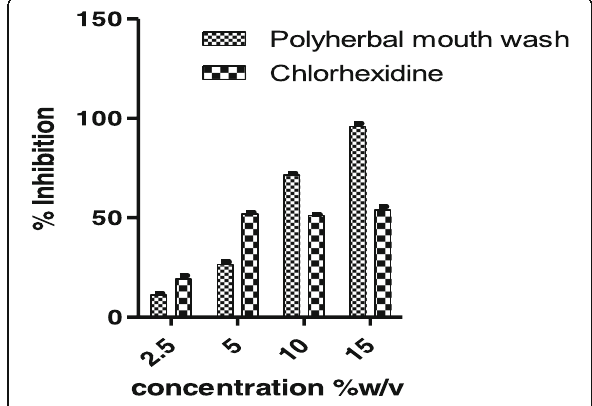
Fig. 6 Gtf inhibitory effects of Polyherbal mouth rinse and